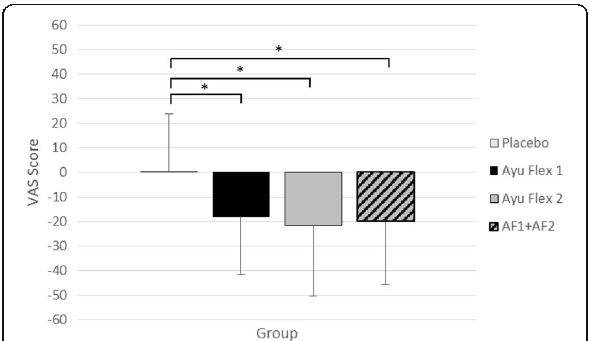
Fig. 8 Mean ± SD changes in levels of knee discomfort (subgroup analysis in subjects with scores of 30 mm or higher at the initial screening visit). AyuFlex 1 ( p = 0.003), AyuFlex 2 ( p = < 0.001),